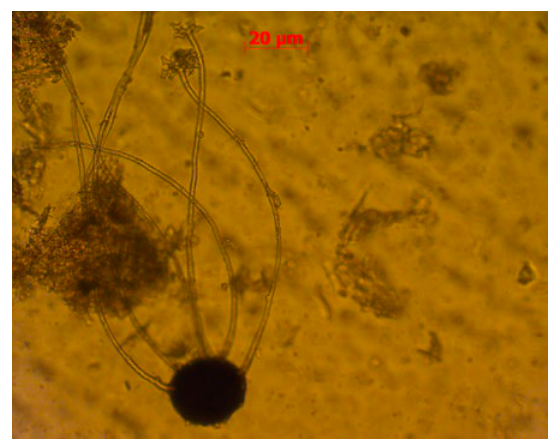
Figure 2. Brown necrosis of infected catalpa flowers.